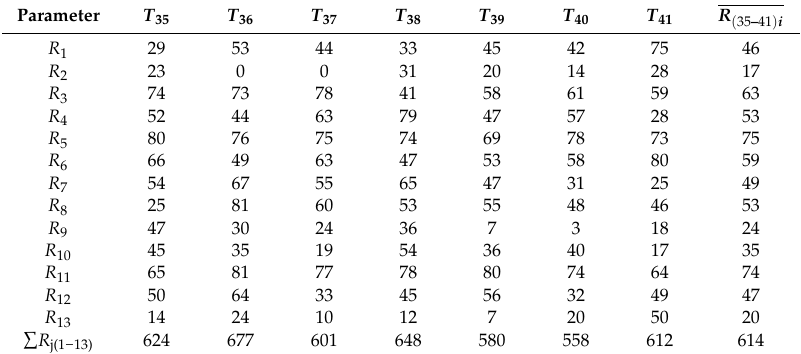
Table A20. Ranking of T j territories on land activity, North Caucasian Federal District. Parameter